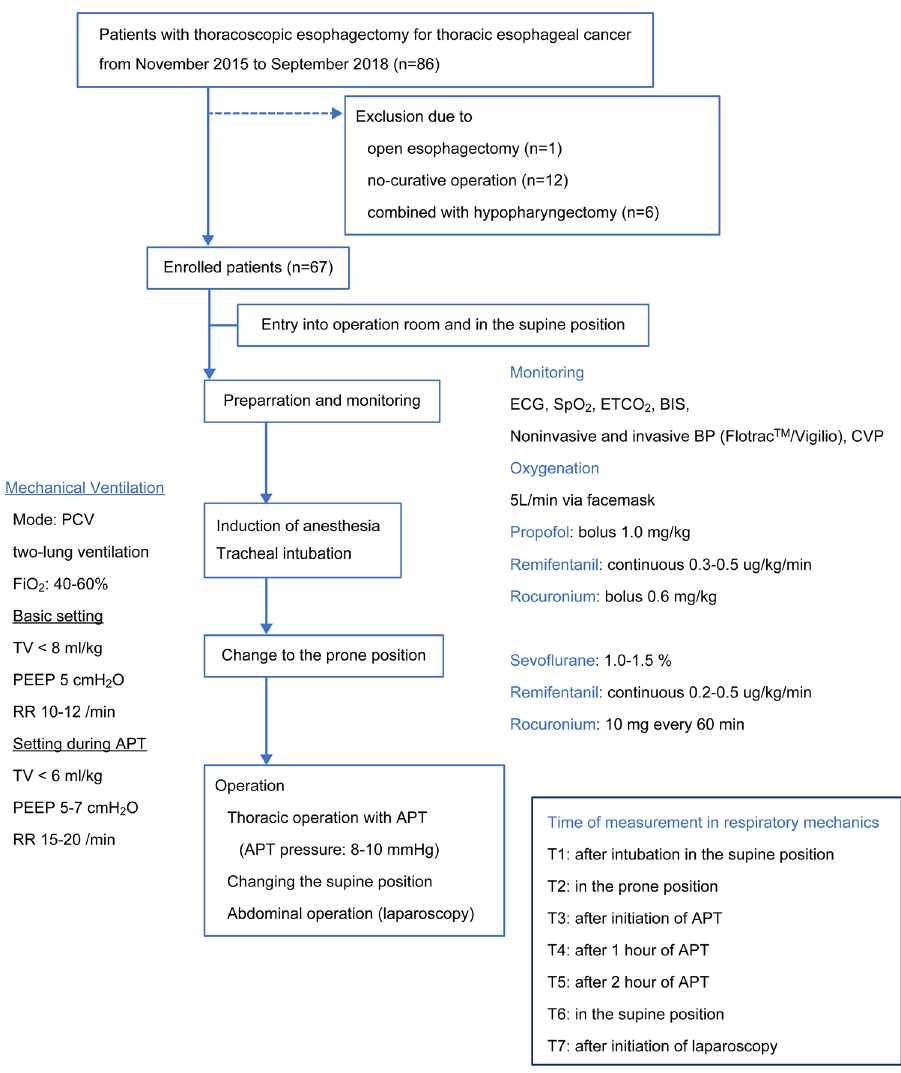
Figure 1. Summary of the longitudinal study design and consort diagram of patients enrolled. BIS: bispectral index, BP: blood pressure, ECG: electrocardiogram, ETCO 2: end-tidal CO 2 monitoring, FiO2: fraction of inspired oxygen, PEEP: positive end-expiratory pressure, PCV: pressure control ventilation, APT: artificial pneumothorax, TV: tidal volume, RR: respiratory